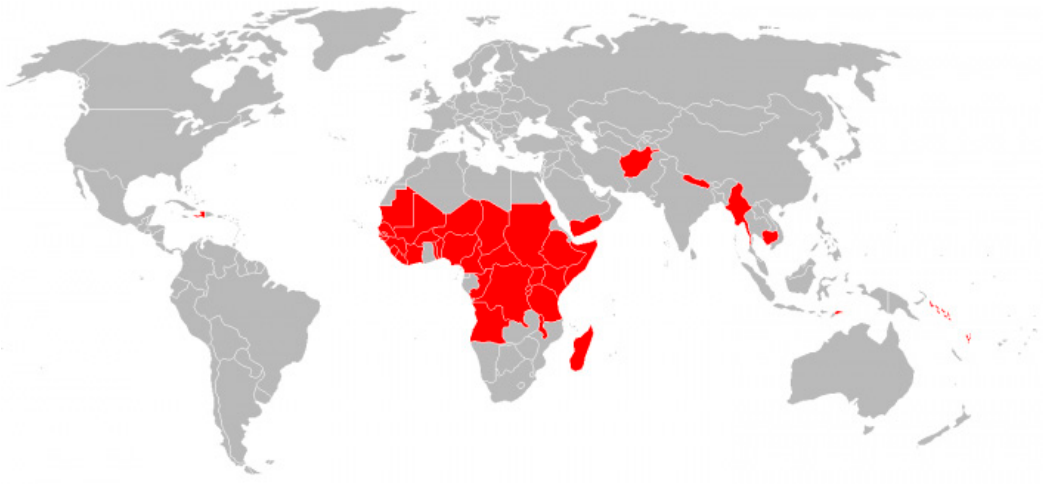
Figure 1. Countries shaded in red (dark shade) if final electricity consumption per capita in 2012 was less than 250 kilowatt hours. Data are available for 133 developing countries. The most populous country for which data are unavailable is Eritrea. Sources: [2,38].